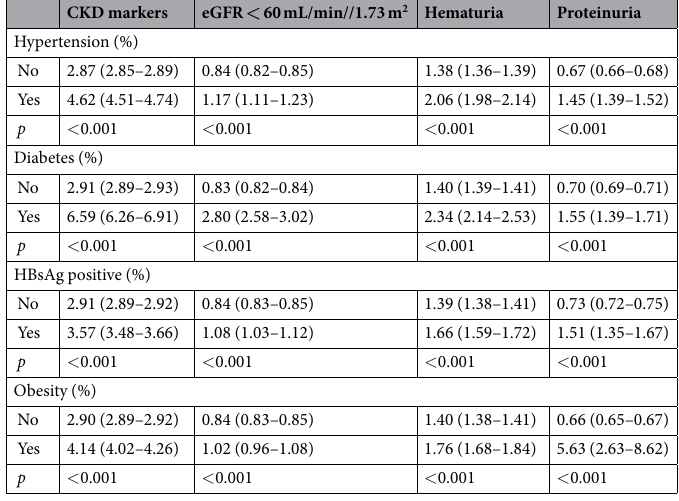
Table 4. The prevalence of CKD indicators of the married population with fertility desire by chronic diseases in rural China. Data are represented as % (95% CI). CKD: chronic kidney disease. EGFR: estimated glomerular filtration rate. Obesity: body-mass index ≥ 28 (kg/m 2 ). HBsAg: hepatitis B virus surface antigen. CI: confidence